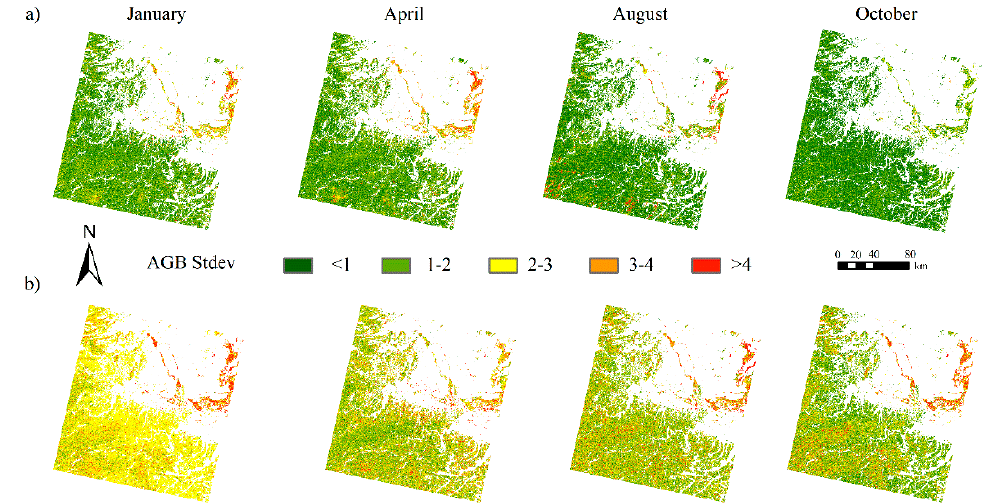
Figure 5. Spatial distribution of forest aboveground biomass (AGB) using seasonal images under different scenarios: ( a ) The total vegetation; ( b ) forest types including coniferous forest, broadleaf forest and mixed forest.